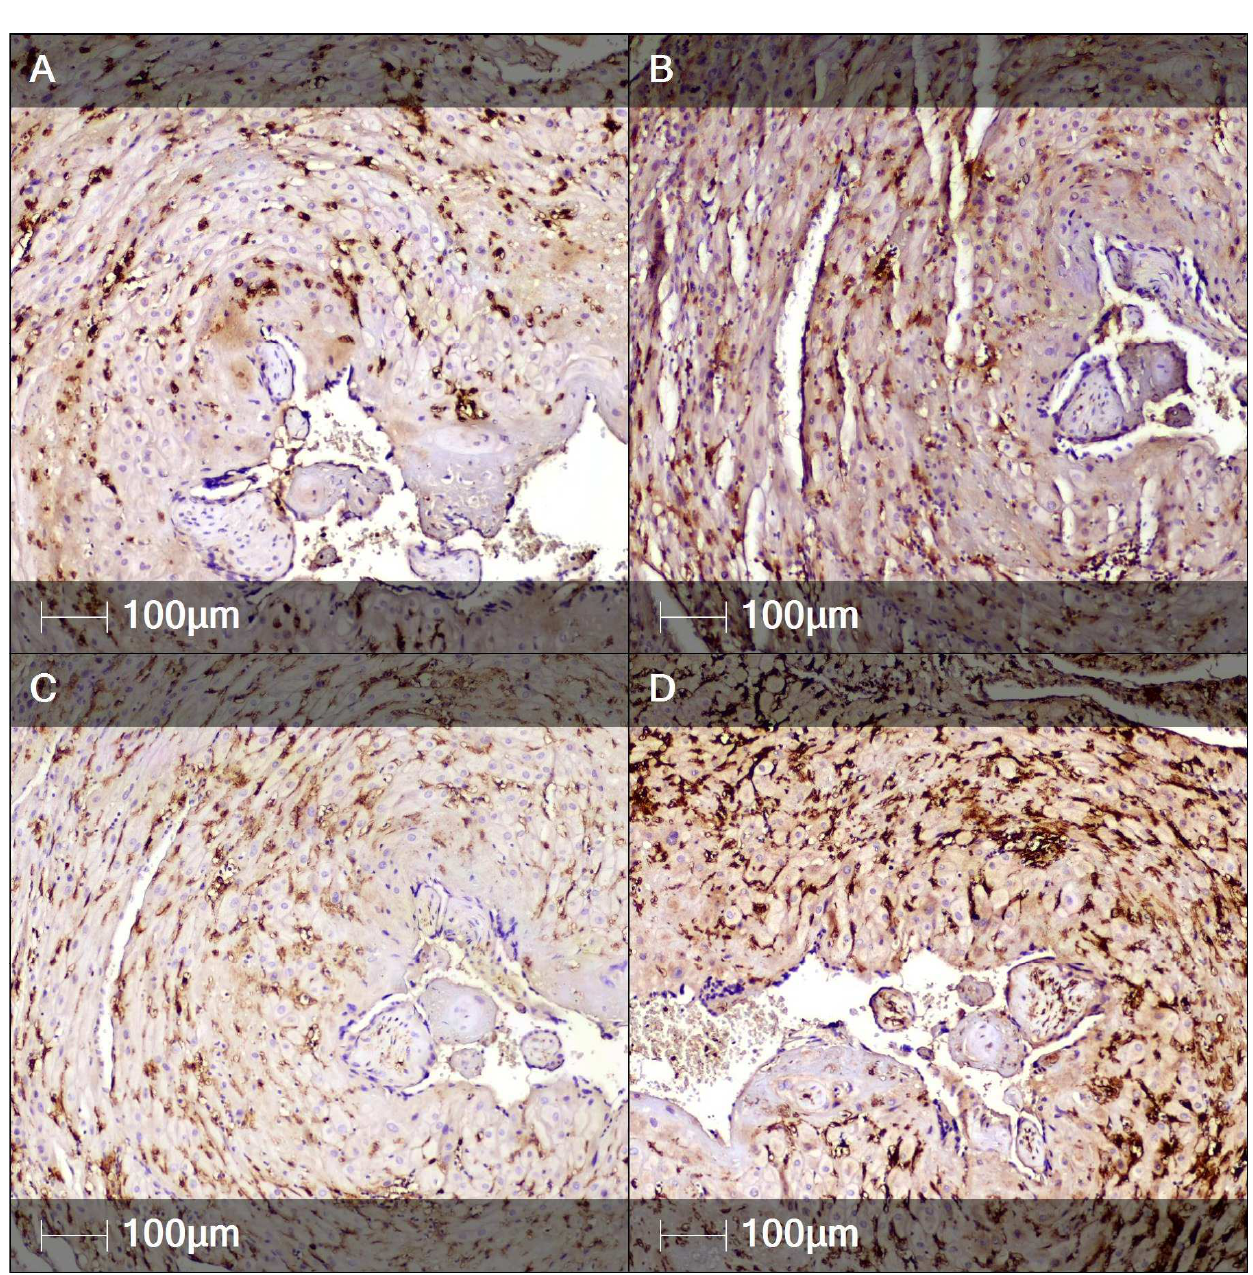
Figure 4. Immunohistochemistry staining of decidua. Representative images of several immune cell markers expressed in the decidua (IHC). ( A ) CD56 staining (natural killer cells); ( B ) CD4 staining (T-helper lymphocytes); ( C ) CD8 staining (cytotoxic T lymphocytes); ( D ) CD14 staining (mono- cytes).